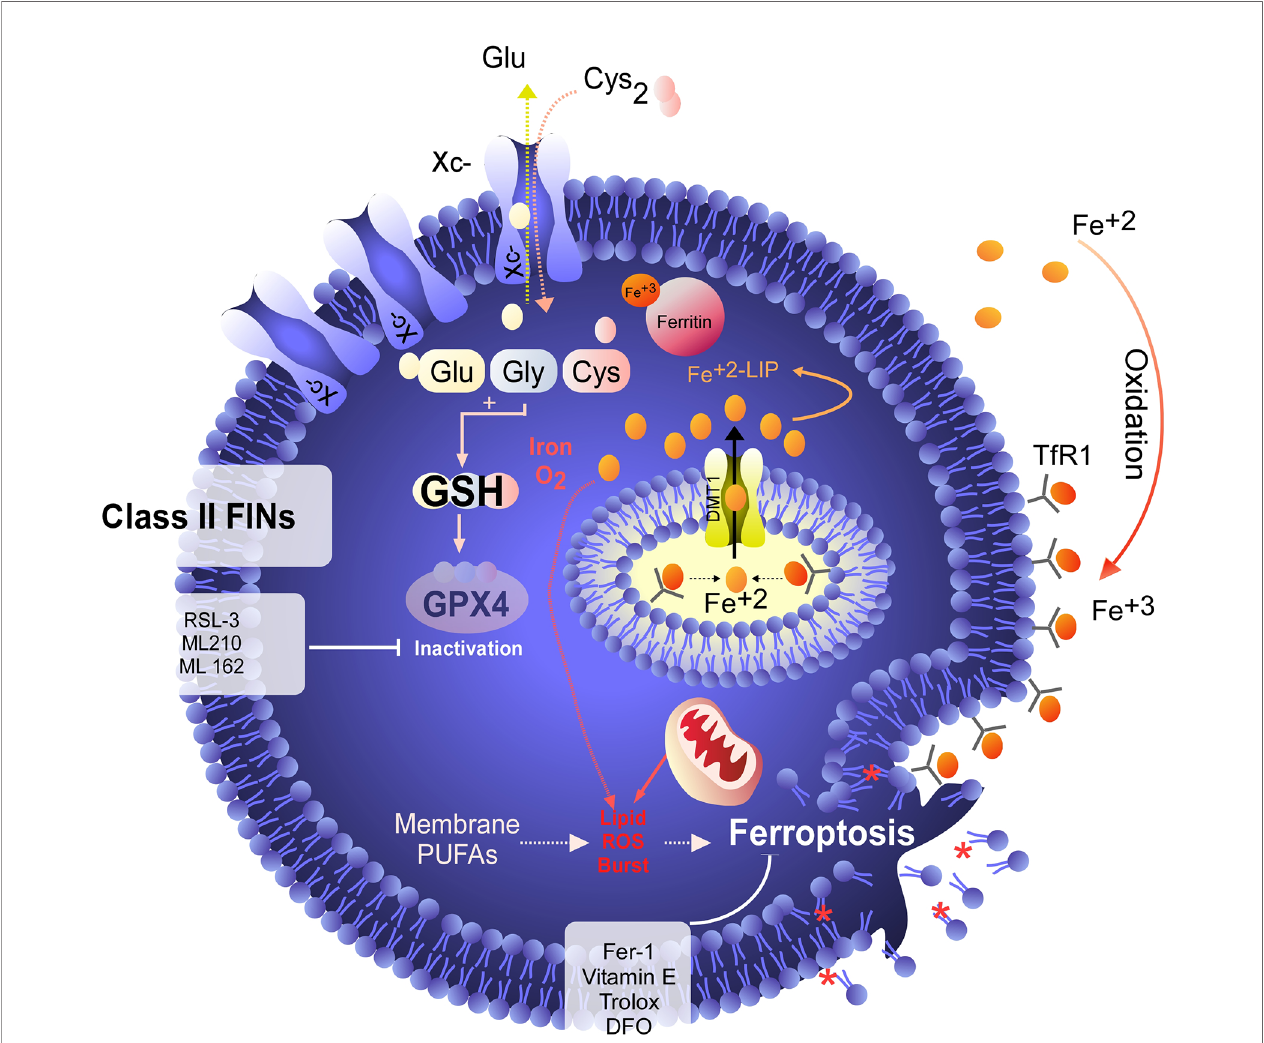
FIGURE 3 | GPX4 as a target for ferroptosis induction. Unlike class I FINs, which indirectly inactivate GPX4, class II FINs such as RSL-3 directly inhibit GPX4, triggering ferroptosis independent of the GSH level. Direct inhibition of GPX4 results in rapid induction of ferroptosis, which can be inhibited by RTA or iron chelators. However, cell death is not inhibited by the recovery of cysteine